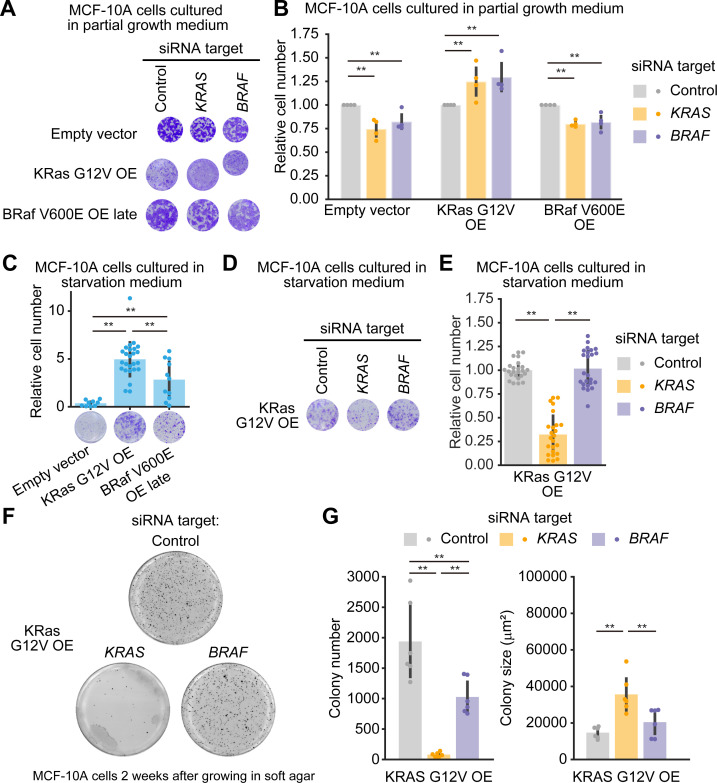
Evaluation of oncogenic KRAS or BRAF addiction in MCF-10A cells overexpressing KRAS G12V or BRAF V600E.(A and B) Cell growth assays following siRNA-mediated negative control, KRAS, or BRAF ablation in parental MCF-10A, KRAS G12V OE, and BRAF V600E OE late cell lines grown in the partial growth medium. Three days after transfection with siRNA, relative cell densities were determined by crystal violet staining. (A) Representative 96-well plates are shown. (B) The mean relative cell number is shown with the SD. The numbers of experiments are as follows: Parental, n = 4; KRAS G12V OE, n = 4; BRAF V600E OE late, n = 4. Dots indicate actual data points. (C) Cell growth assays in empty vector-introduced MCF-10A, KRAS G12V OE, and BRAF V600E OE late cell lines grown in the starvation medium for four days with the indicated siRNA. Relative cell densities were determined by crystal violet staining. (lower) Representative 96-well plates are shown. (upper) Mean relative cell numbers are shown with the SD (empty vector control, n = 9; KRAS G12V OE, n = 25; BRAFV600E OE late, n = 11). Dots indicate actual data points. (D and E) Cell growth assays following siRNA-mediated negative control, KRAS, or BRAF ablation in the KRAS G12V OE cell line grown in the starvation medium. Four days after transfection with siRNA, relative cell densities were determined by crystal violet staining. (D) Representative 96-well plates are shown. (E) The mean relative cell number is shown with the SD (Control, n = 25; KRAS, n = 24; BRAF, n = 24). Dots indicate actual data points. (F) Representative images of MTT-stained colonies of the indicated cells seeded in soft agar for 2 weeks. (G) The mean number of colonies (left) and the mean colony size (μm2)(lower) are shown with the SD (KRAS G12V OE, n = 6). Dots indicate actual data points. * p < 0.05, ** p < 0.01.